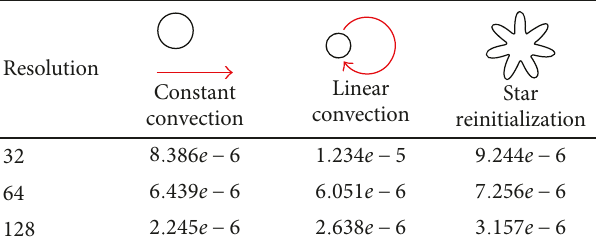
Table 3: Regression errors at various resolutions.